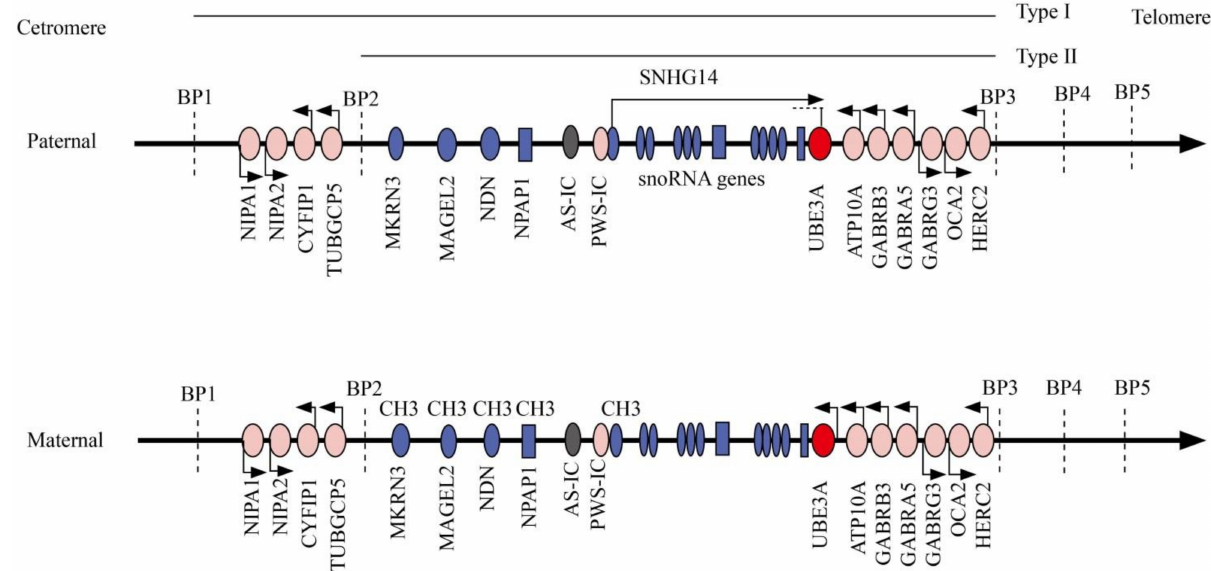
Figure 1. Human chromosome 15q11–13 region. Paternal and maternal chromosome 15q11–13 regions around the Angelman syndrome imprinting center (AS-IC) and Prader–Willi syndrome imprinting center (PWS-IC) are presented. Paternally expressed genes are indicated as deep blue, maternally expressed genes are indicated in red, and genes expressed from both parental alleles are indicated as pink. Transcription orientation is noted with arrows. Class I and class II deletions are indicated as horizontal lines. BP, breakpoint cluster region; CH3, methylation; snoRNA, small nucleolar RNA; SNRPN , small nuclear ribonucleoprotein-associated protein N; UBE3A , ubiquitin–protein ligase